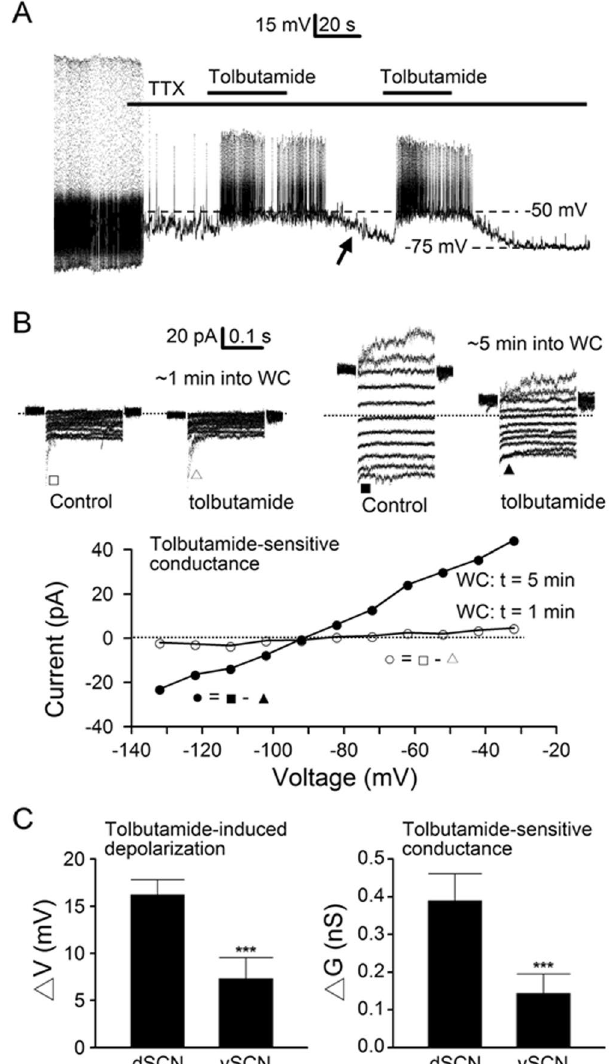
Figure 3. Tolbutamide effects on membrane potential and conductance under whole cell conditions with ATP- free pipette solution. ( A ) A representative dSCN neurone showing voltage responses to tolbutamide during the first few minutes into whole cell recordings. Note the much larger depolarisation by tolbutamide following spontaneous hyperpolarisation (marked by arrow), indicating the activation of K ATP channels. Nighttime recordings (ZT 14). ( B ) A representative dSCN neurone showing the current responses to tolbutamide recorded at ~1 and ~5 min after breaking into whole cell (WC) recordings (top panels). Note the large leakage currents and their marked blockade by tolbutamide at ~5 min into WC (top right two panels). Bottom panel: comparison of the I-V relations of tolbutamide-sensitive conductance recorded at ~1 ( ○ ) and ~5 min ( ● ) into WC. Daytime recordings (ZT 8). ( C ) Summary of tolbutamide-induced depolarisation (left panel) and tolbutamide-sensitive conductance (right panel), both being larger in dSCN than vSCN neurones. Baseline resting potential after ~3–5 min into WC: dSCN ( − 68 ± 3 mV; n = 17), vSCN ( − 64 ± 4 mV; n = 12). Baseline resting conductance after ~3–5 min into WC: dSCN (0.85 ± 0.11 nS; n = 23), vSCN (0.64 ± 0.10 nS; n = 22). Dotted lines are zero